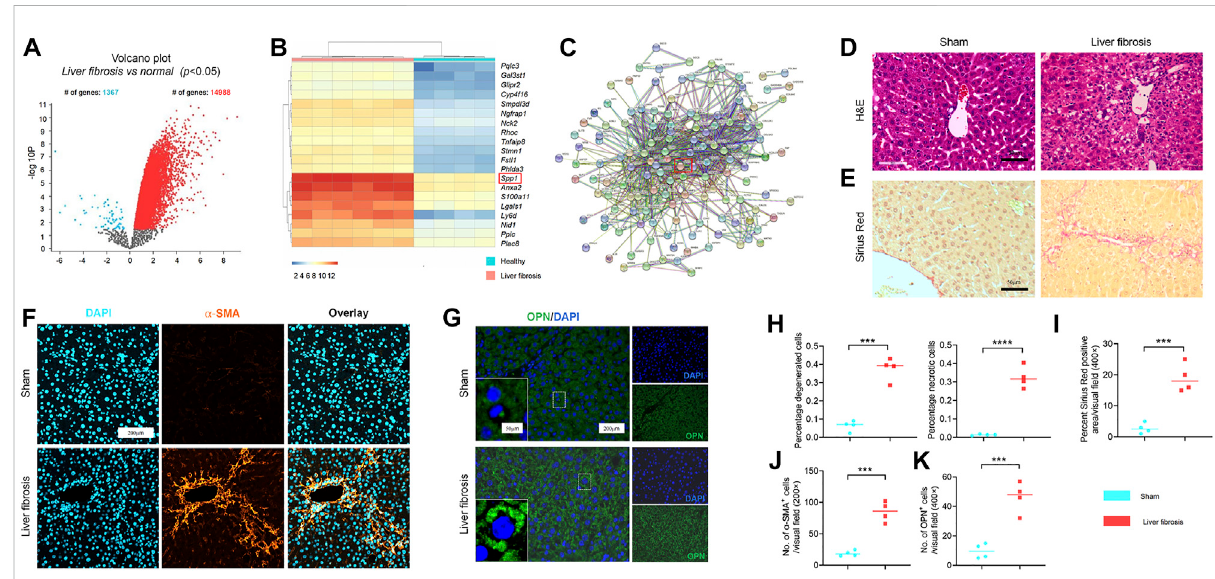
FIGURE 1 AccumulationofOPNduringprogressionofliver fi brosismurinemodel. (A) Volcanoplotsshowingthenumberofdifferentiallyexpressedgenes (DEGs) in GSE55747; (B) Heatmap for the top 20 DEGs in GSE55747. (C) Protein-protein interaction networks (PPI) of OPN and ECM-related genes according to GSE71379. (D,H) Representative H&E staining (D) of liver sections from CCl 4 -treated and olive oil vehicle-treated mice. (H) Percentage of degenerated and necrotic hepatocytes per visual fi eld. n = 4 mice per group; Scale bar: 50 μ m. (E,I) Sirius red staining (E) in each group with indicated treatments. (I) Percent sirius red positive areas per visual fi eld (%). n = 4 mice per group; Scale bar: 50 μ m. (F,G,J,K) α − SMA (F) and OPN (G) immuno fl uorescence (IF) staining in mice (5 visual fi elds for each tissue analyzed). The average number of α − SMA (J) and OPN (K) positive cells. n = 4 mice per group; Scale bar: 200 μ m. Data in Figure 1 are expressed as mean ± SD. Individual dots represent distinct mice in graphs. Unpaired t – test was used in fi g (D – G,J,K) . p < 0.001 ***, p < 0.0001